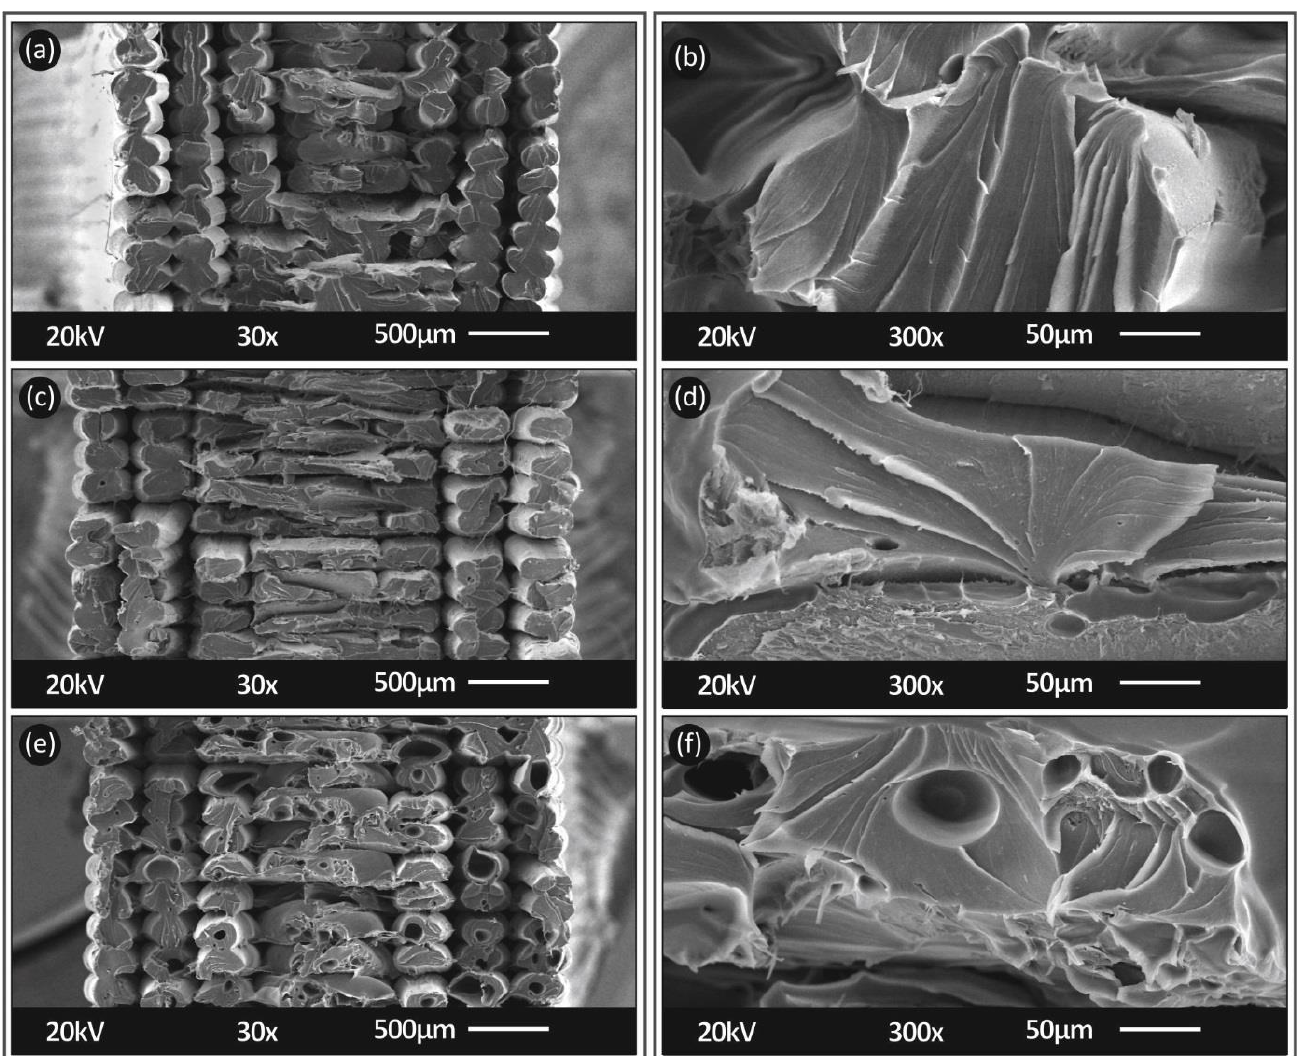
Figure 8. Fracture area of tensile specimens in two different magnifications for all tested materials, ( a , b ) Pure PC, ( c , d ) PC CNF 0.5 wt.%, ( e , f ) PC CNF 1.0 wt.%.